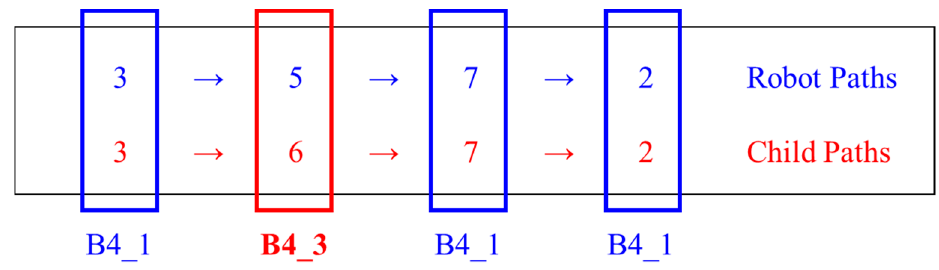
Figure 7. Indicators B4_1 (correct path) and B4_3 (incorrect path).